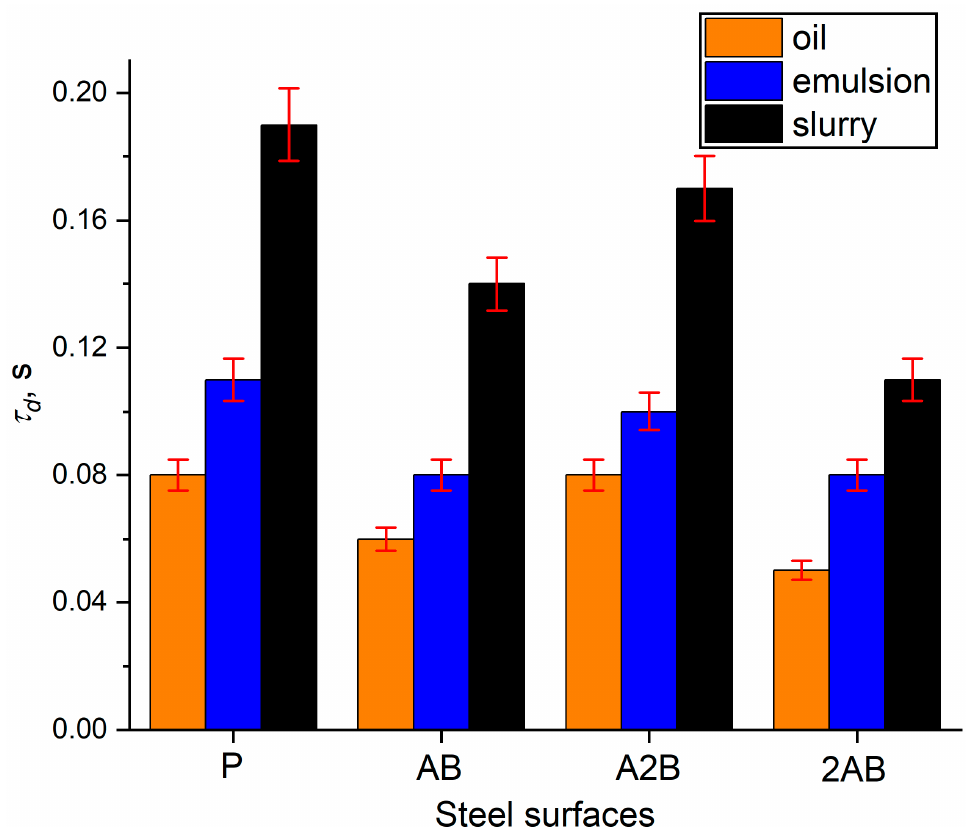
Figure 9. Ignition delay times of fuel droplets (liquid oil in the usual state, emulsion, and slurry) under a conductive heat supply.